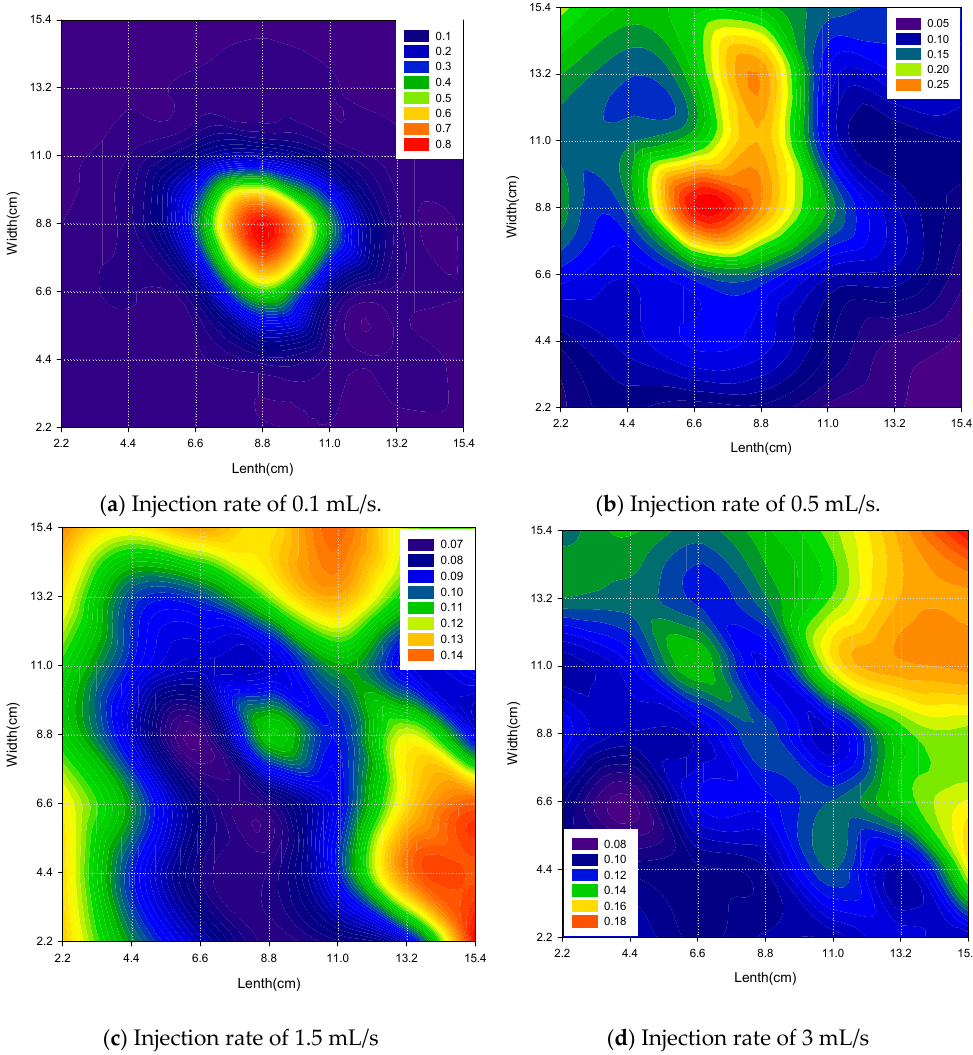
Figure 3. Ion precipitation contour distribution at different injection rates.